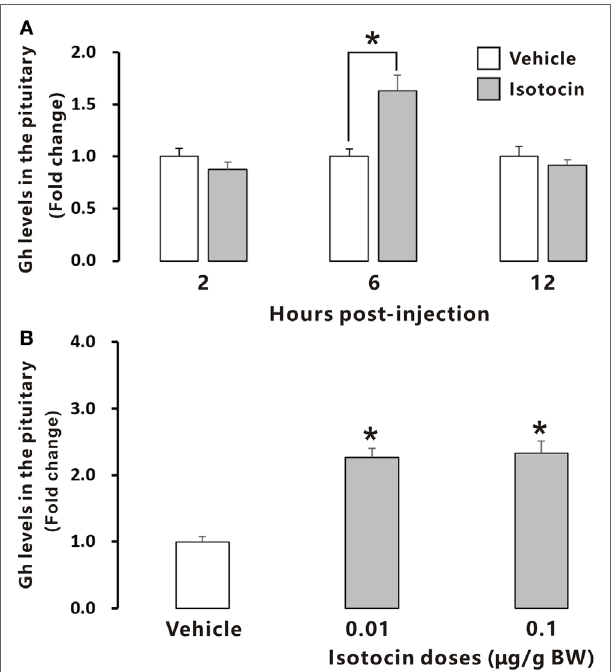
FigUre 8 | Relative growth hormone (Gh) levels in the pituitary of female ricefield eels after intraperitoneal injection of isotocin (Ist) or 0.65% NaCl (Vehicle control). (a) The time-course effects of Ist (0.1 µg/g BW) at 2, 6, and 12 h after injection; (B) dose-dependent effects of Ist (0.01 and 0.1 µg/g BW) at 6 h after injection; BW, body weight. Data were expressed as fold change relative to the corresponding vehicle control. Bars represent mean ± SEM ( n = 11). * P < 0.05 vs. the corresponding